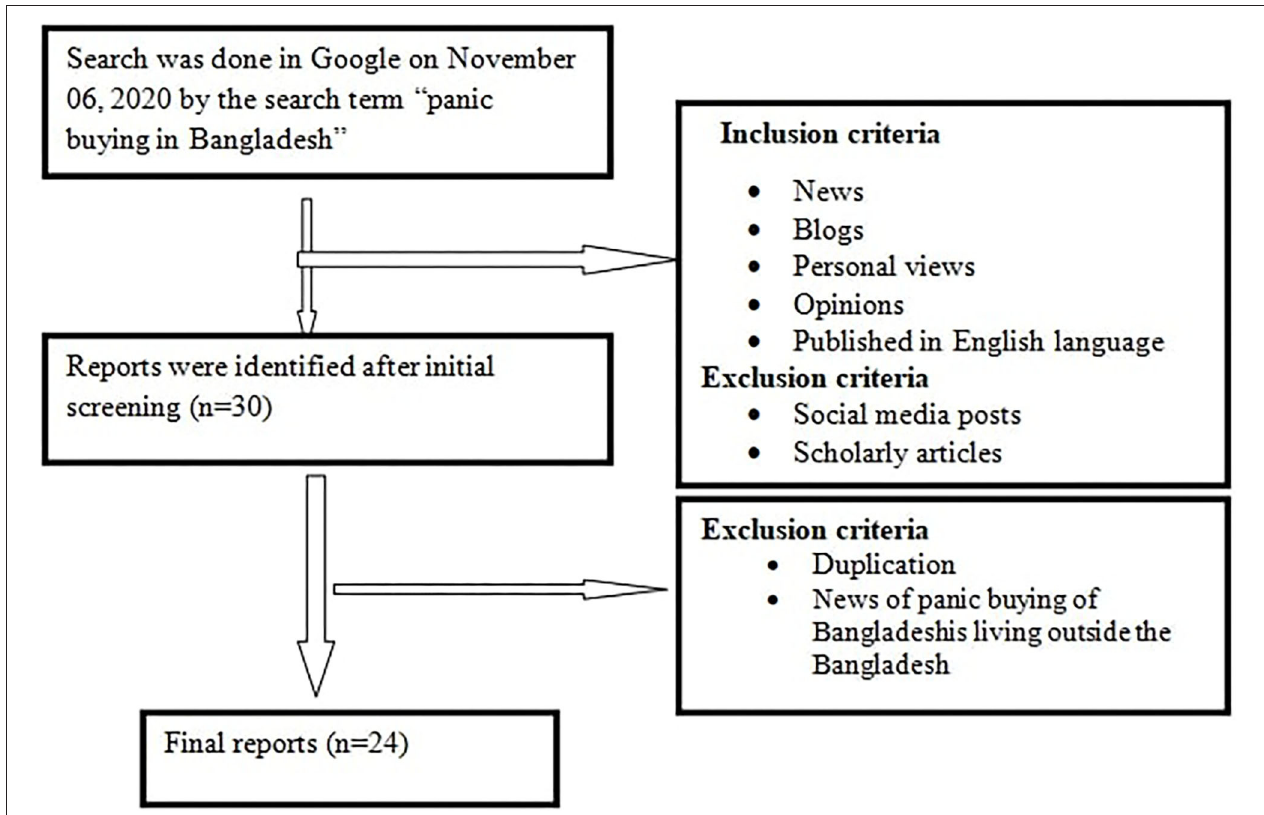
FIGURE 2 | Flow chart showing study sample